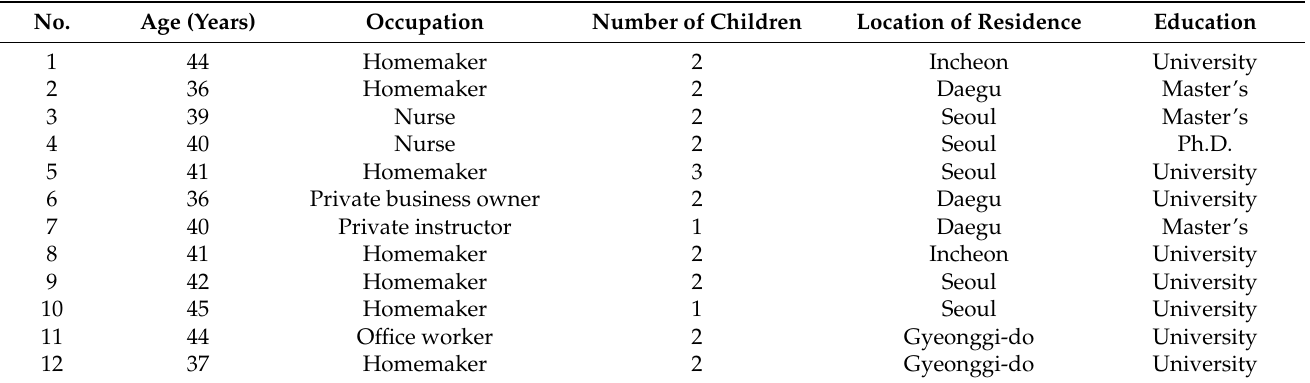
Table 1. Characteristics of the participants ( N = 12).